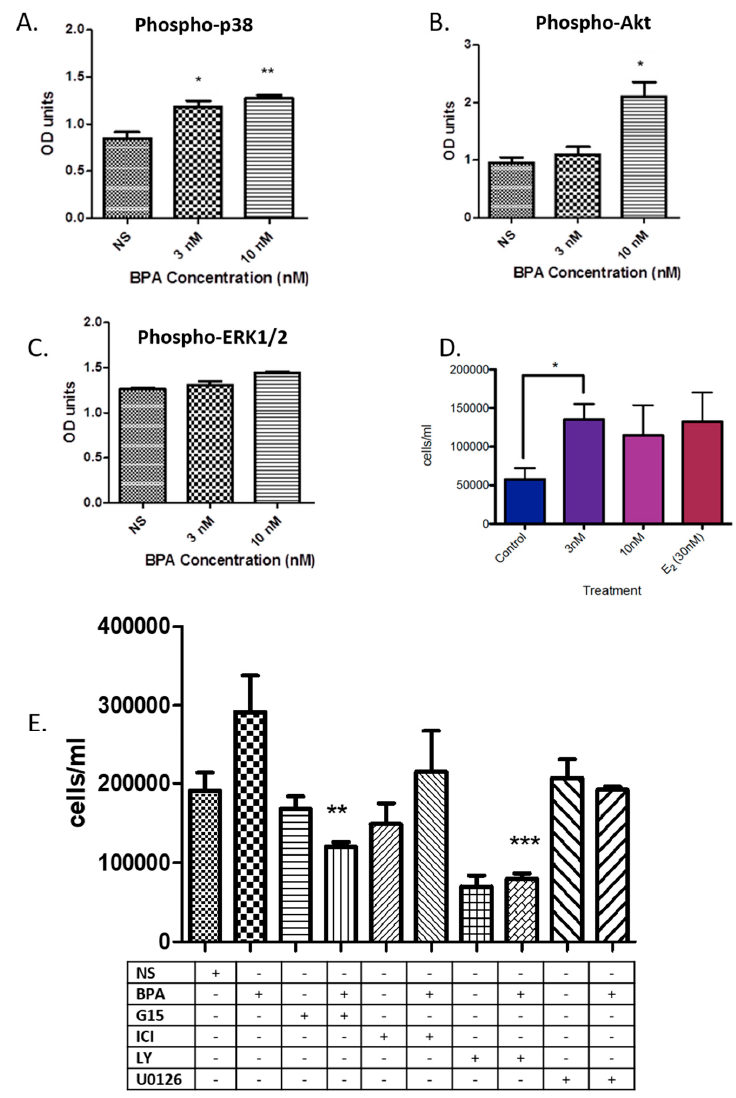
Figure 1. ( A , B ). Relative amount of phospho-p38 (A) and phospho-Akt after 60 min of bisphenol A (BPA) treatment (3 nM and 10 nM). Treatment of BeWo cells with 3 nM and 10 nM BPA significantly increased the expression of p-p38 after 60 min (* p < 0.05 and ** p < 0.01 compared to no supplement (NS)) (A). Treatment of BeWo cells with 10 nM BPA significantly increased the expression of p-AKT after 60 min (* p < 0.05 compared to NS) (B). Both protein expression of the housekeeping gene GAPDH and of total p38 remained unchanged; ( C ). There was no difference in the phosphorylation status of ERK1/2 when cells were treated with BPA for 60 min; ( D ). Changes in BeWo cell number treated with 3 nM BPA, 10 nM BPA, and 30 nM estradiol (E2). The 3 nM BPA treatment significantly increased cell number compared to controls ( p < 0.05), while there was a notable, but not significant, increase in number when cells were treated with 10 nM BPA or 30 nM E2; ( E ). Changes in the number of BeWo cells treated with 3 nM BPA and / or estrogen receptor (ER) antagonists (i.e., ICI 182,780 (ICI): ER α and ER β inhibitor, G15: GPR30 inhibitor). Cell number of BPA-treated cells was significantly decreased when treated with G15 ( p < 0.05). There was also a significant decrease in cell number when cells were treated with LY294002 (LY), as well as for the treatment with BPA + LY294002 when compared to controls and treatment with only BPA (*** p < 0.001 compared to control). There was a decrease in cell number when cells were treated with U0126 or BPA + U0126 when compared to treatment with only BPA just short of significance ( p =